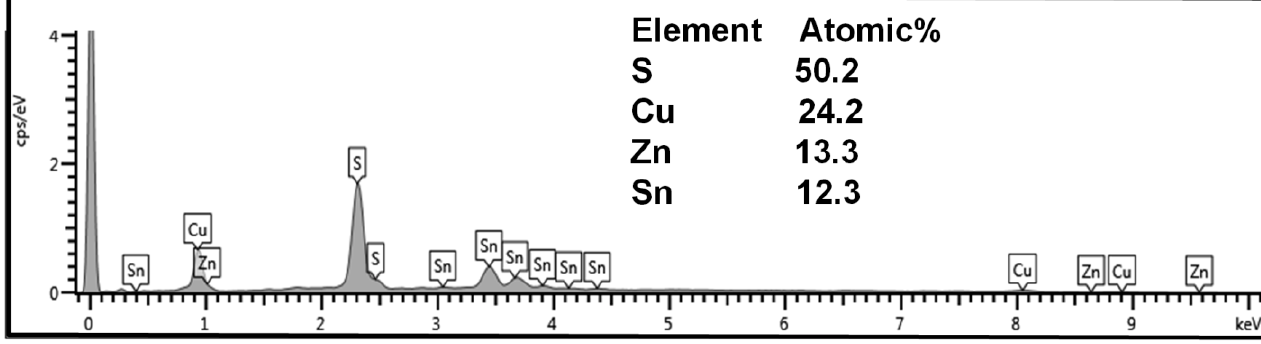
Figure 5. Energy-dispersive X-ray spectroscopy of the sample DIO-20 mg/mL, showing the elemental composition.